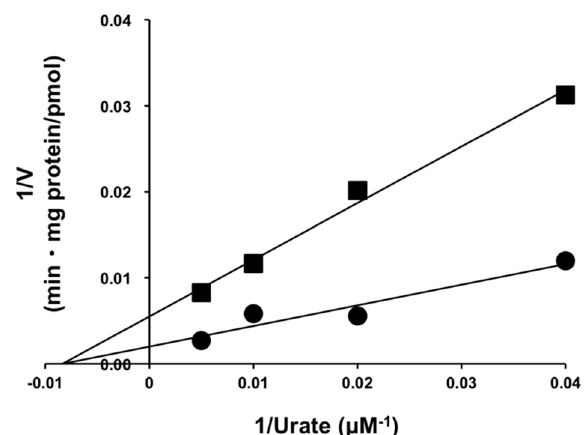
Figure 5. Kinetics analysis for the inhibitory effect of osthol on the uptake of uric acid via URAT1. HEK293/PDZK1 cells were transiently transfected with human URAT1. The cells were incubated with uric acid (25, 50, 100, and 200 µM) with (closed square) or without (closed circle) osthol (100 µM) at 37 °C for 1 min. The uptakes of uric acid into the cells (V) were measured, and a Lineweaver–Burk plot was made. Each symbol is expressed as the mean of quadruplicate data. Linear regression lines calculated using the least-square method are